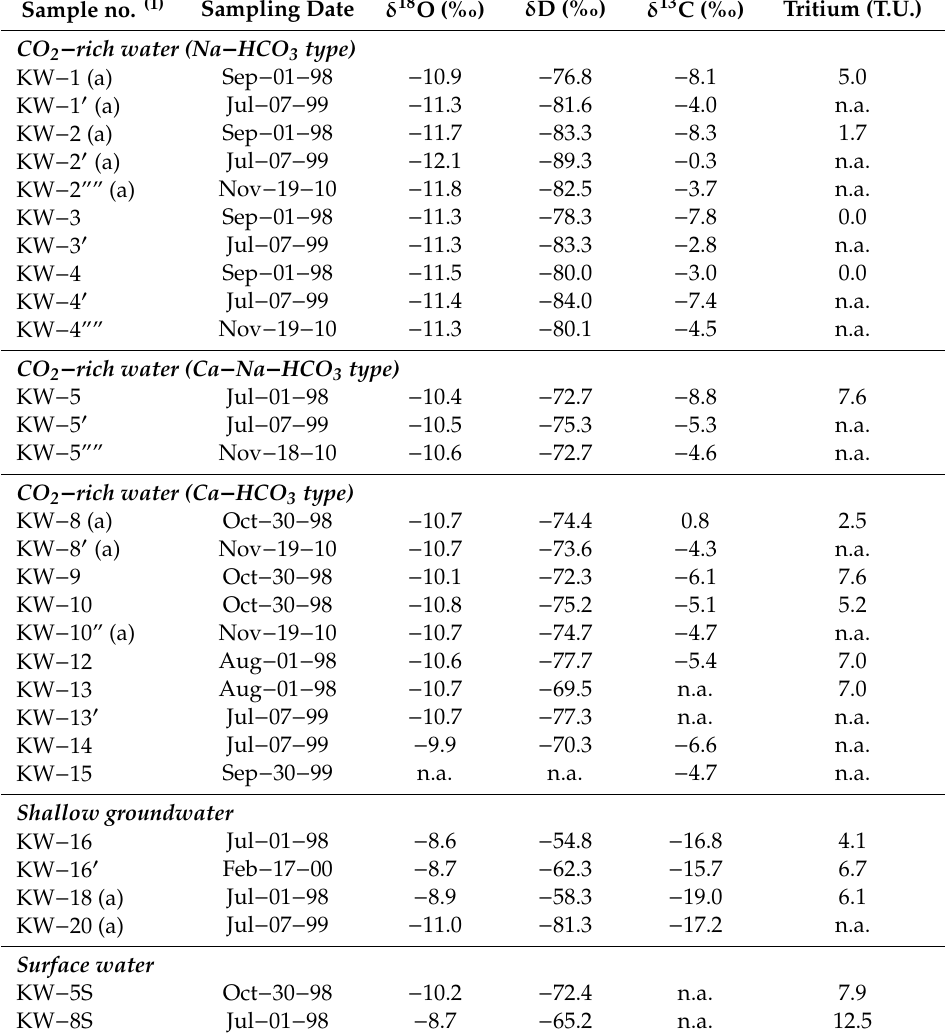
Table 3. Isotopic compositions of water samples in the Gangwon Province of South Korea. CO 2 − rich water is grouped based on the Piper diagram (see Figure